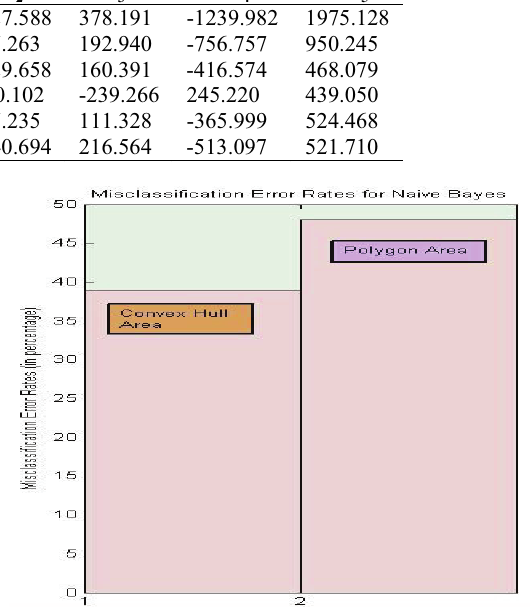
Fig.13. Misclassification error rates for Naïve Bayes’